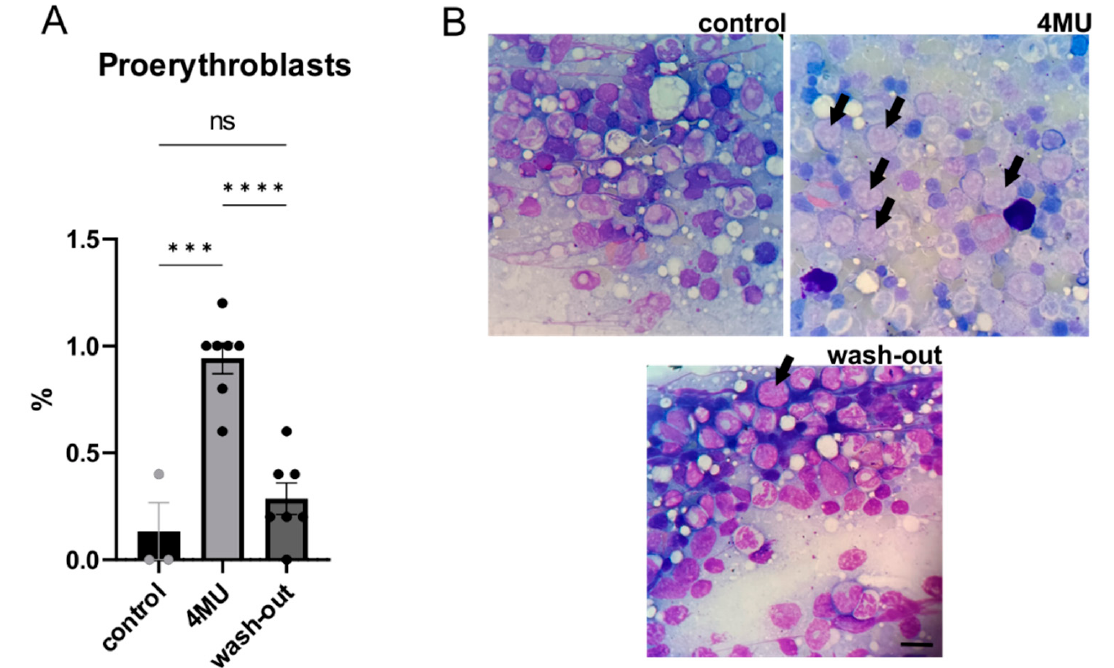
Figure 8. Relative number of proerythroblasts in the bone marrow. ( A ) shows the bar graph comparing the relative number of proerythroblasts in 1000 cells in bone marrow per the smear; ( B ) shows representative images of the bone marrow smear. Black arrows show the proerythroblasts; scale bar: 20 µm; n = 8; *** p < 0.01; **** p < 0.001 by one-way ANOVA with Tukey’s multiple comparisons test. ns: no significance. Table 1. The biomechanical properties of skin and tendon in control, 4MU and wash-out